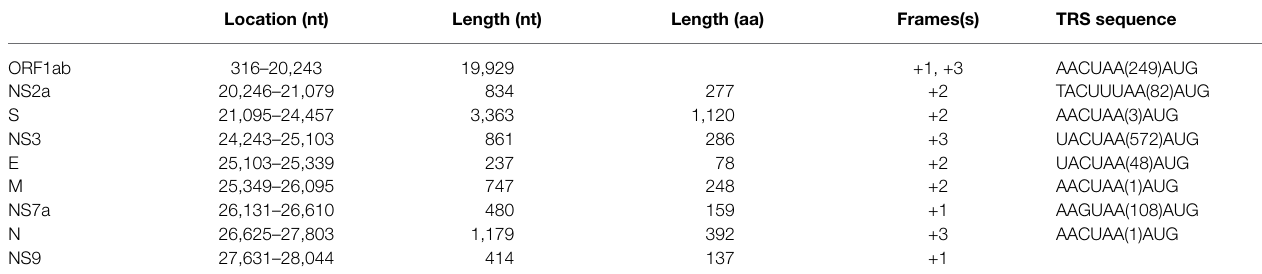
TABLE 1 | Coding potential and putative transcription-regulatory sequences (TRS) of PPCoV. Location (nt) Length (nt) Length (aa) Frames(s) TRS sequence